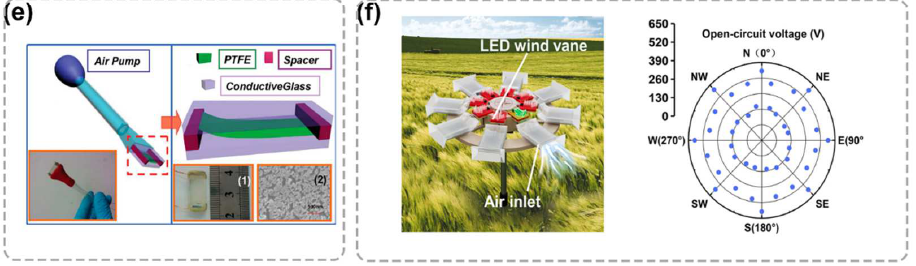
Figure 6. Applications of WD-TENG. ( a ) Experimental set-up and characterization of fluttering behavior of AF-TENG. Reproduced with permission of [71], Copyright 2017, Elsevier. ( b ) Schematic diagram and working mechanism of ferroelectric BTO disk polarized by WD-TENG. Reproduced with permission of [72], Copyright 2017, Elsevier. ( c ) Self-powered air purification system. Reproduced with permission of [73], Copyright 2020, ACS Nano. ( d ) Application scenario of the TENG-based wind barrier. Reproduced with permission of [16], Copyright 2020, Nano Energy. ( e ) Schematic diagram and (inset) digital photograph of the designed ATNG sensor. Reproduced with permission of [74], Copyright 2014, American Chemical Society. ( f ) WD-TENG is used to realize self-powered wind vector monitoring. Reproduced with permission of [75], Copyright 2021,